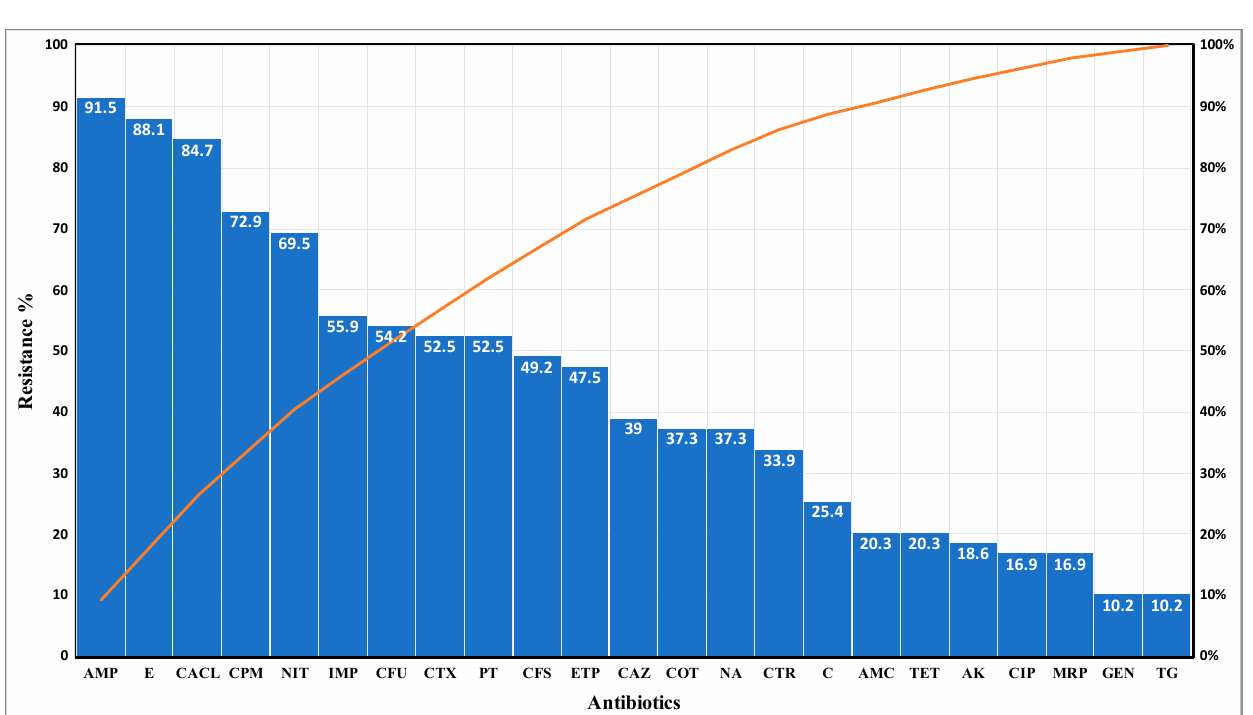
Figure 1. Graph showing the resistance pattern for all antibiotics used in the study. Among E. coli isolates, highest resistance was to imipenem (96.3%), ampicillin (81.5%), ertapenem (74.1%), cefepime (66.7%), and cefoperazone sulbactum (66.7%) and least resis- tance to gentamicin (11.1%), amikacin (14.8%) and ciprofloxacin (25.9%). On the other